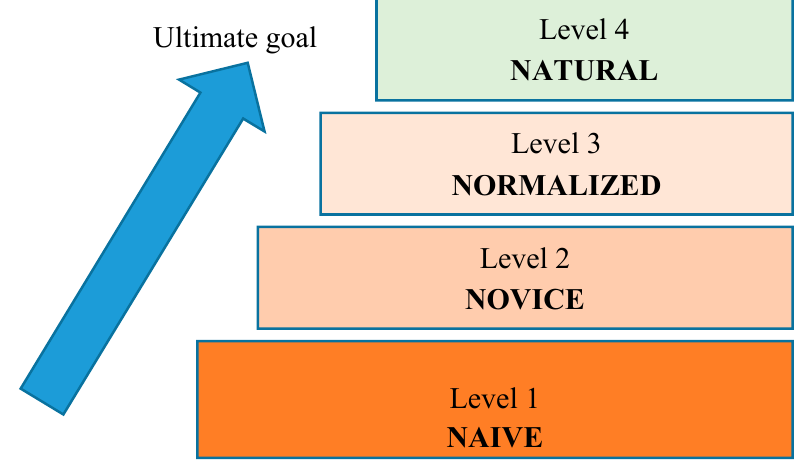
Figure 3. An example of four levels of risk management maturity, Adapted from Arrow [50].